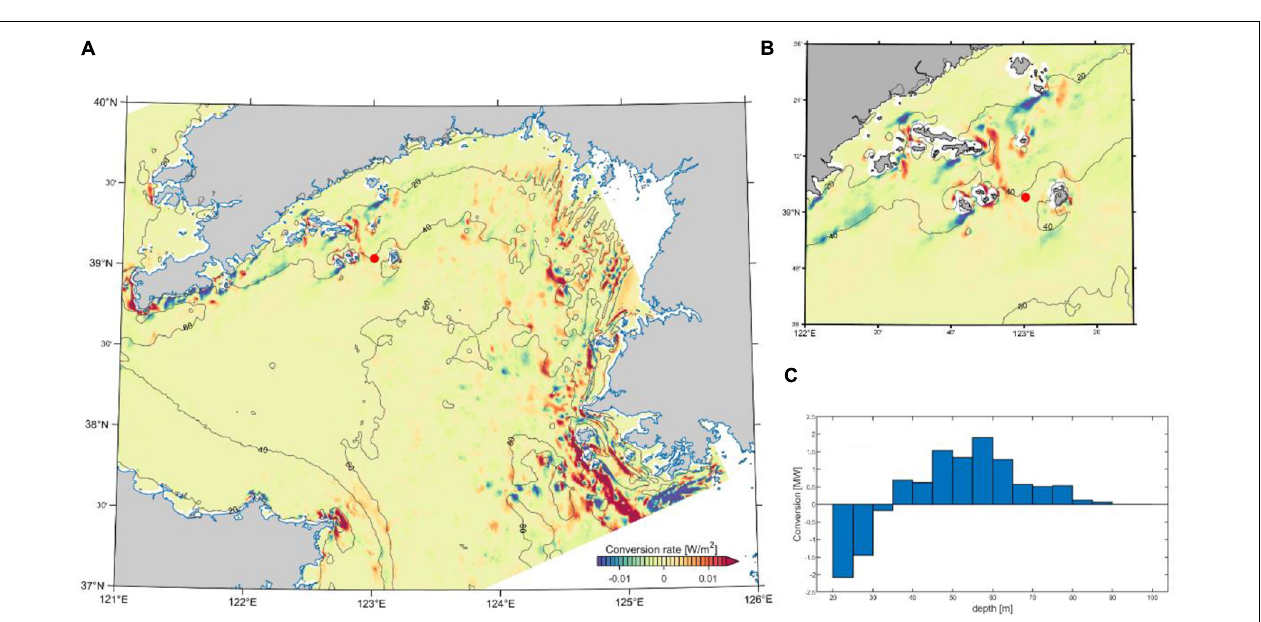
horizontal scale of the internal tide in the Yellow Sea